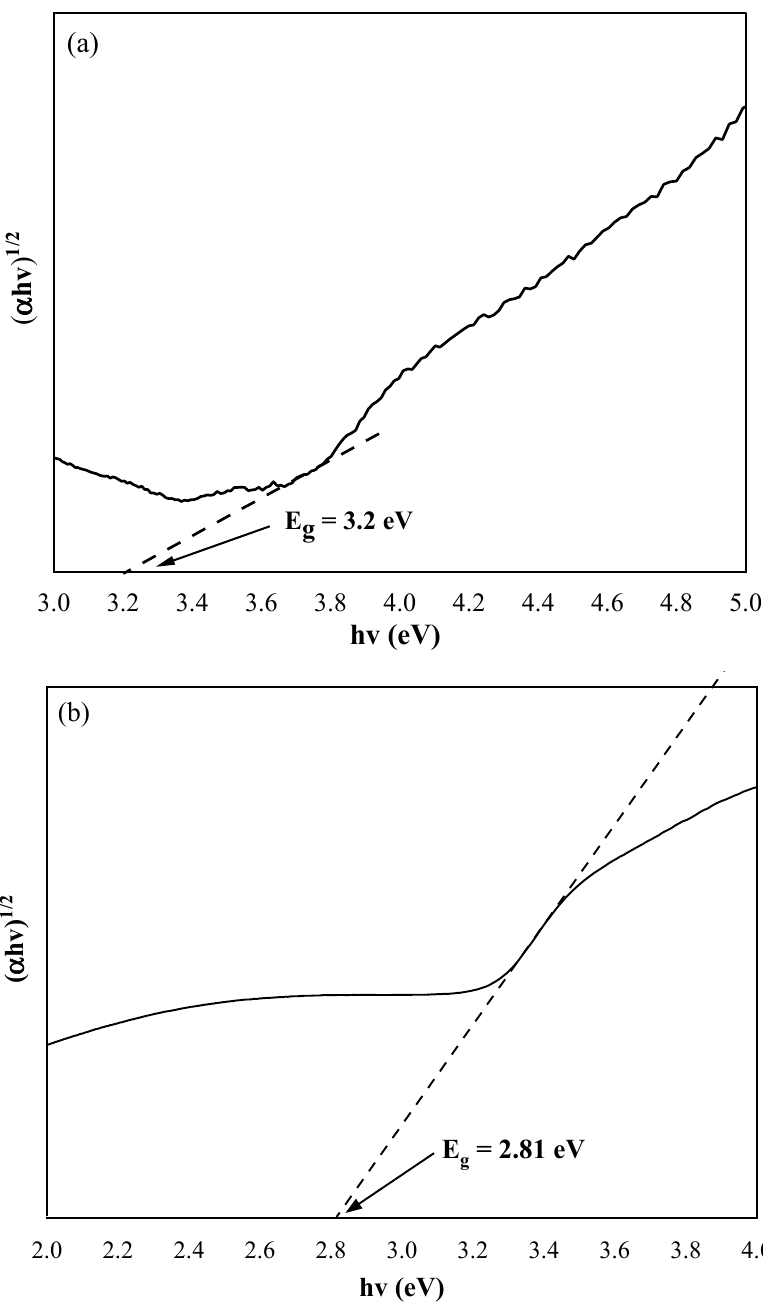
Figure 7. Plot of ( α h ν ) 1 / 2 versus h ν (eV) of ( a ) pure anatase TiO 2 nanotube thin films and ( b ) CdSe–TiO 2 nanotube thin films.